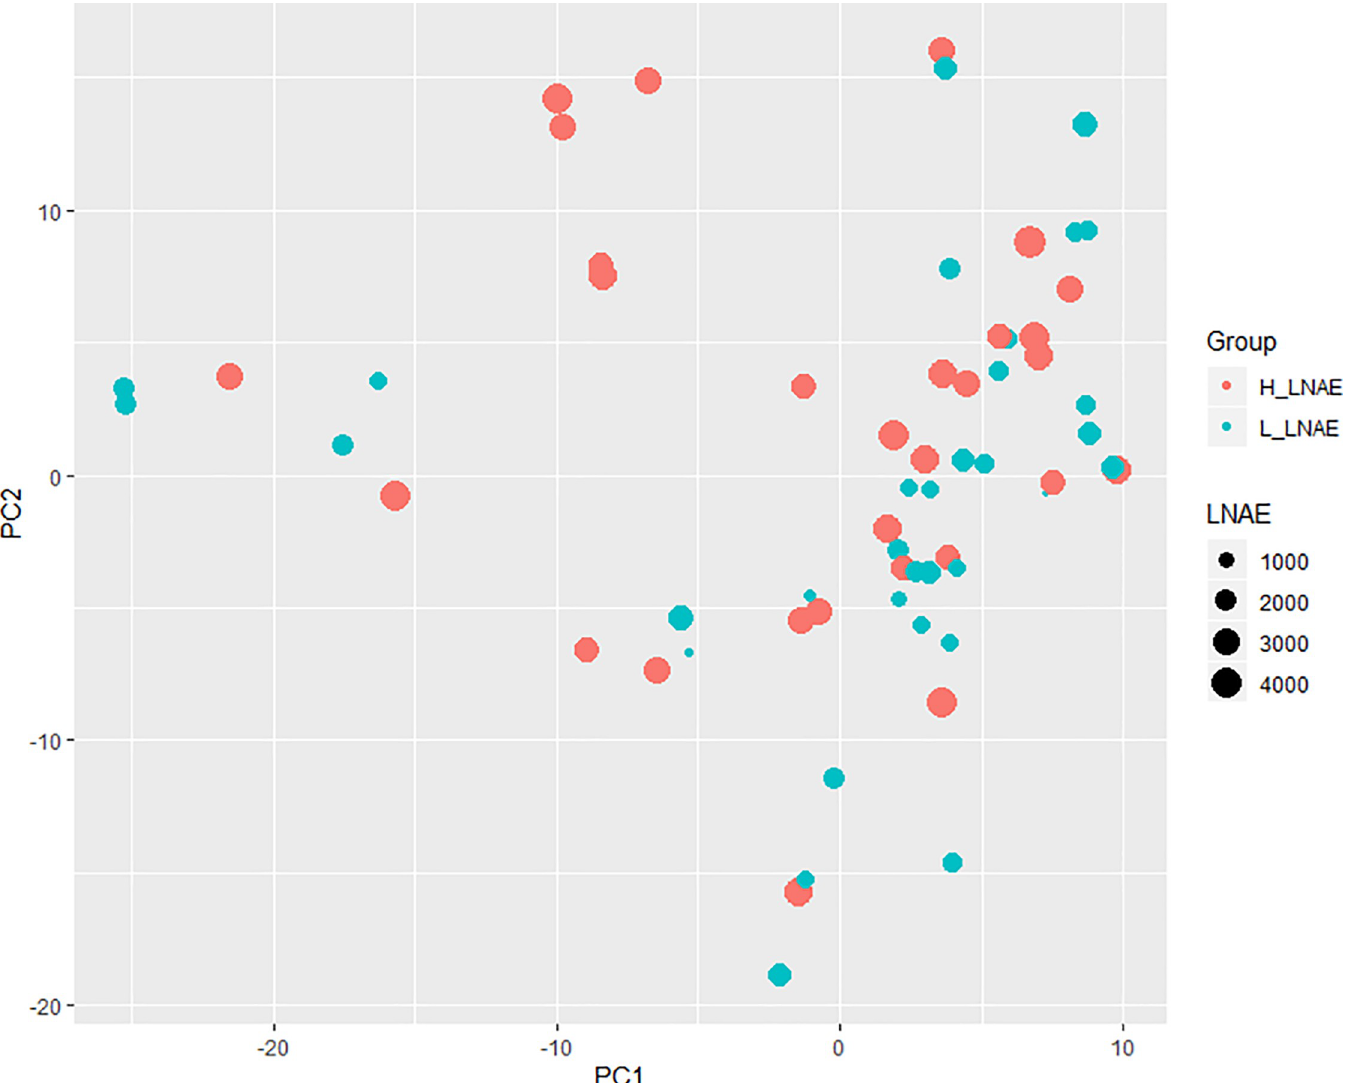
Fig 2. Principal coordinate analysis (PCoA) of 64 maize lines based on 12,050 polymorphic SNPs. The dots representing H_LNAE lines are colored red, while the Low L_LNAE lines are colored blue. The sizes of the dots are proportional to the LNAE values of the lines.